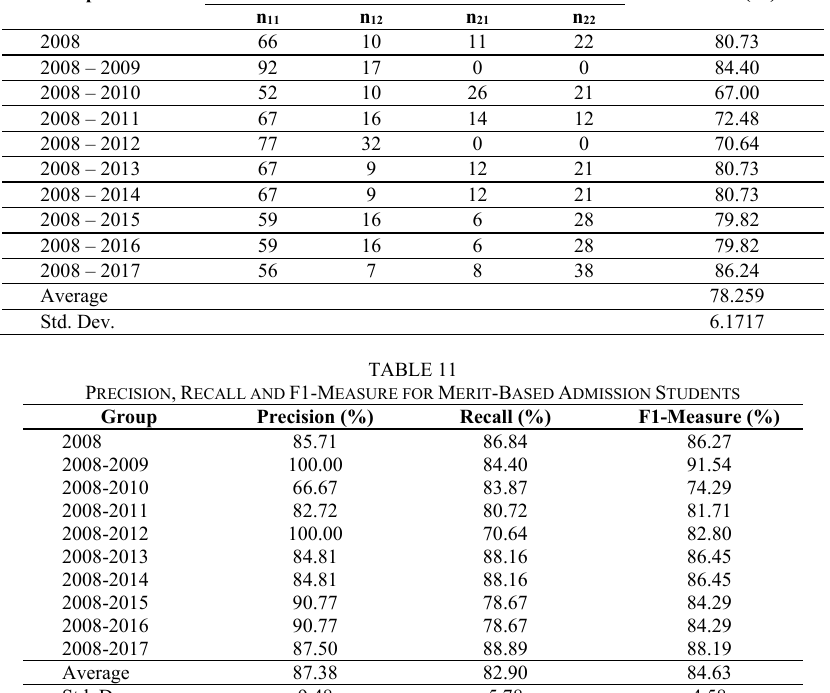
Based on Table 5, the characteristics of students with high GPA are: public school (X1=2), from Java (X2=1), SMU (X3=1), English level 2 (X4=2.2  2) and GPA 3.16 on average. Meanwhile, the characteristics of students